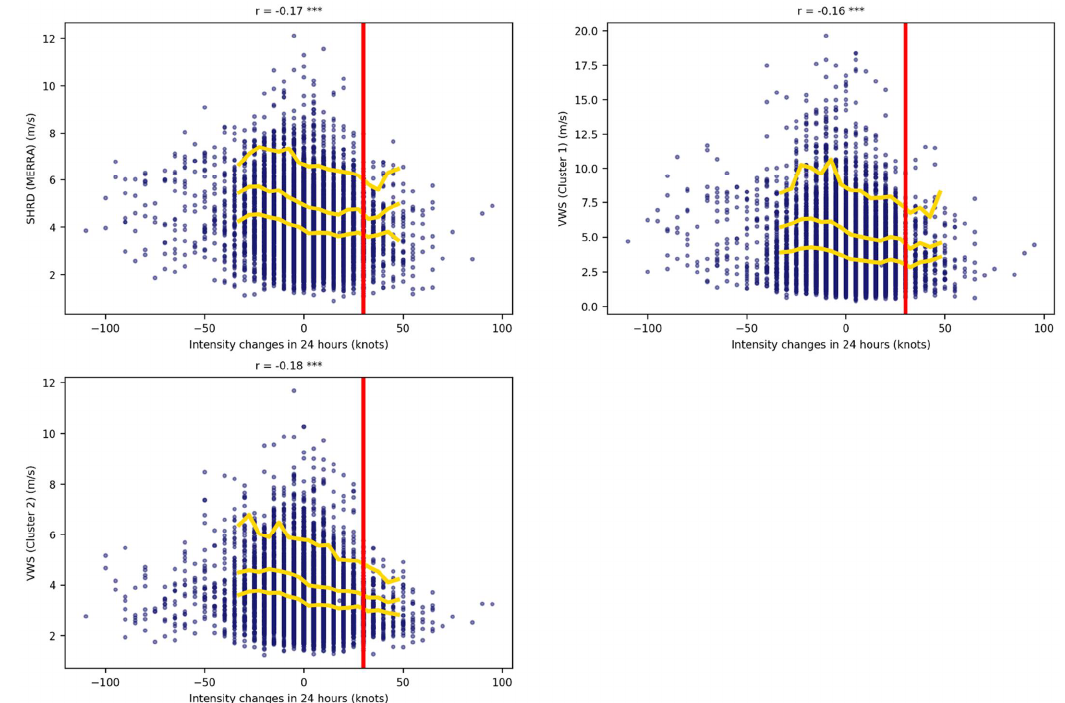
Figure 11. Scatter diagrams of 24-h TC intensity change versus SHRD (MERRA) ( a ), SHRD (Cluster 1) ( b ) and SHRD (Cluster 2) ( c ). The red vertical line in each panel shows the boundary of rapid intensification, and the yellow curves show 95th, 75th, and 50th percentiles in each intensity change bin. Notes: *** p < 0.01.